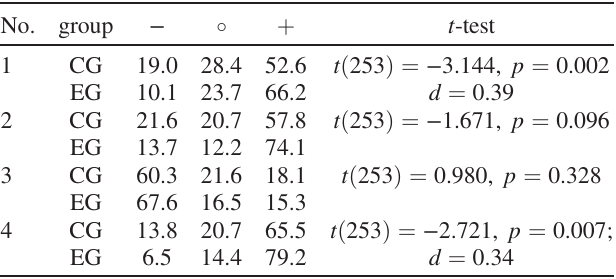
TABLE X. Proportion of students ’ agreements ( þ , rating: rather agree, agree), disagreements ( − , rating: rather disagree, disagree), and undecided votes ( ∘ , rating: undecided) in the items of the scale on conceptions about the probability interpretation of quantum physics (cf. Table III) in % . Deviations from 100% in the row totals are due to rounding. Test statistics of t tests for independent samples are used to examine differences in means between control and experimental groups for each item.